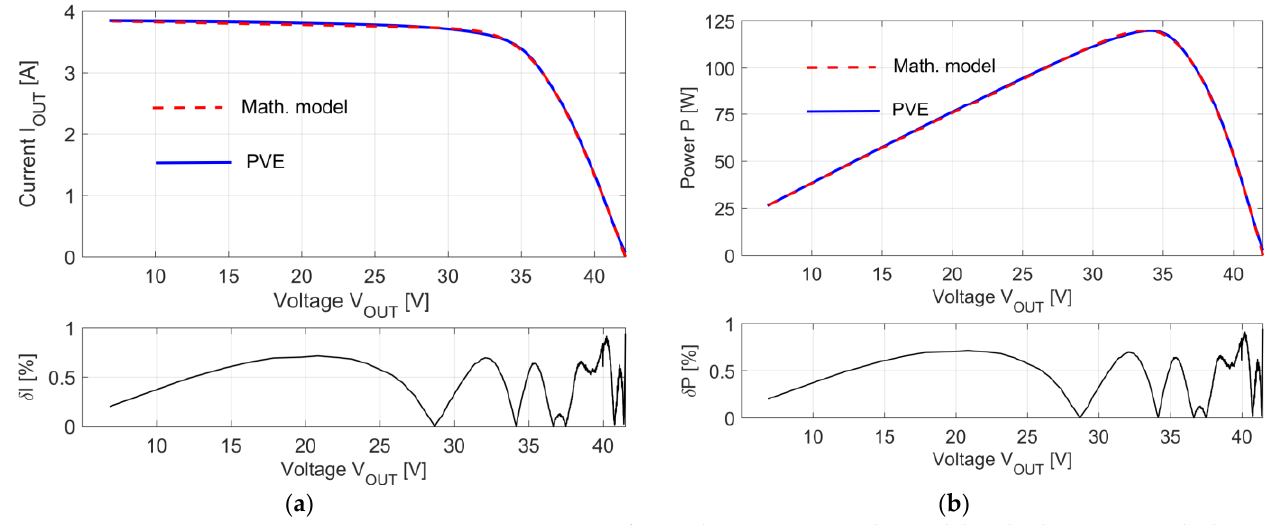
Figure 14. Comparison of PVE characteristics to the model and relative error calculation results: ( a ) Upper curves are the function I OUT = f (V OUT ), bottom curve represents relative error values at each point of the compared plots; ( b ) Upper curves are the function P OUT = f (V OUT ), bottom curve represents relative error values.